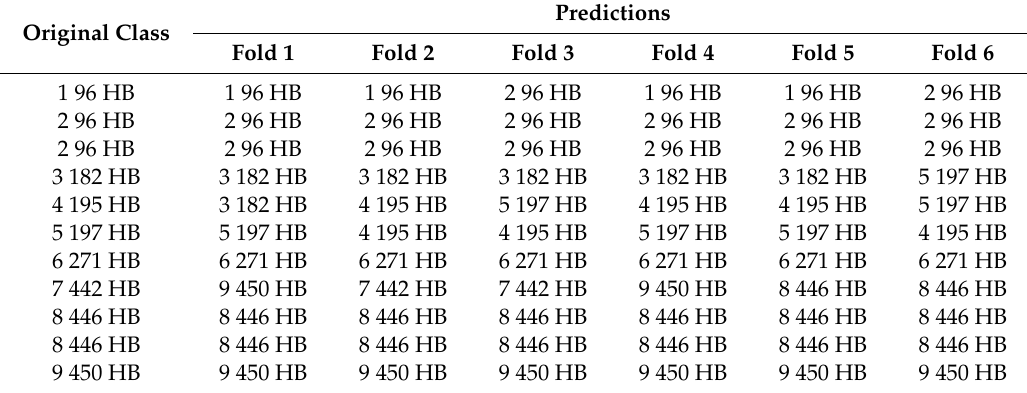
Table 3. Result of classifications by an ensembles of artificial neural networks (ANNs) for each fold.